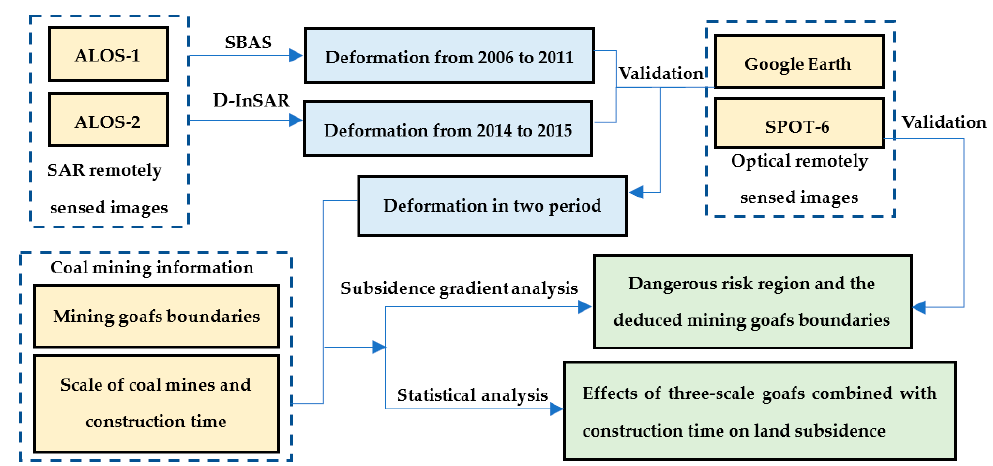
Figure 2. Flowchart of methodology to monitor land deformation over the coal mining area in the study area. Pink represents input data, Blue represents the InSAR output data, Green represents the analysis output data.